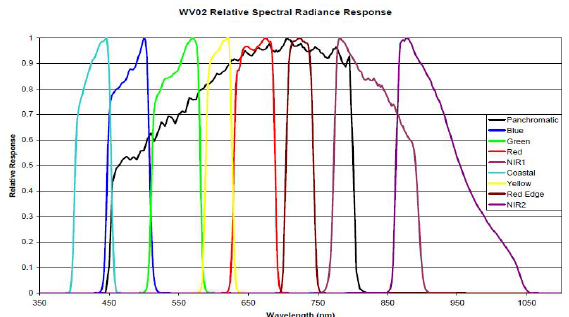
Figure 1 – Spectral response of Worldview II bands. Source: Digital Globe